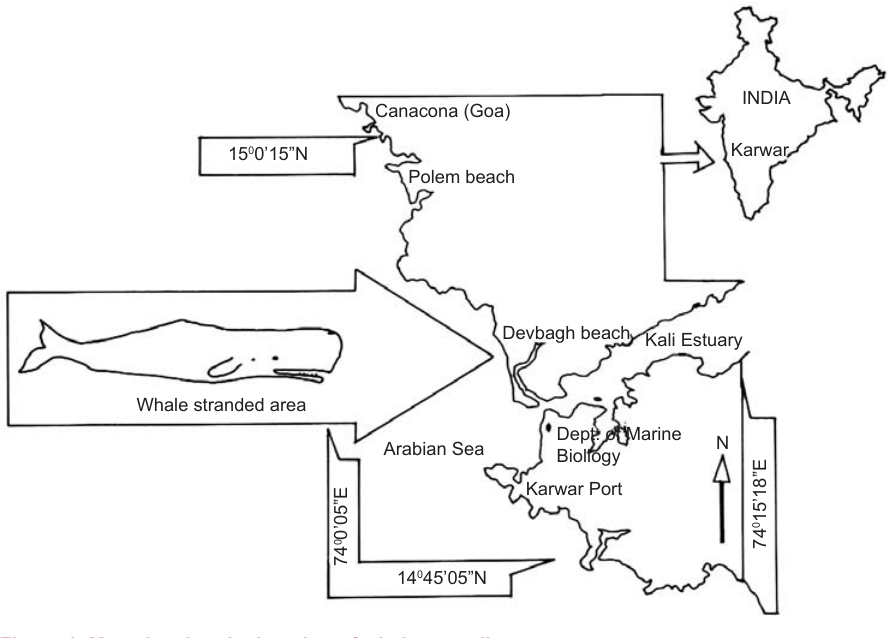
Figure 1. Map showing the location of whale